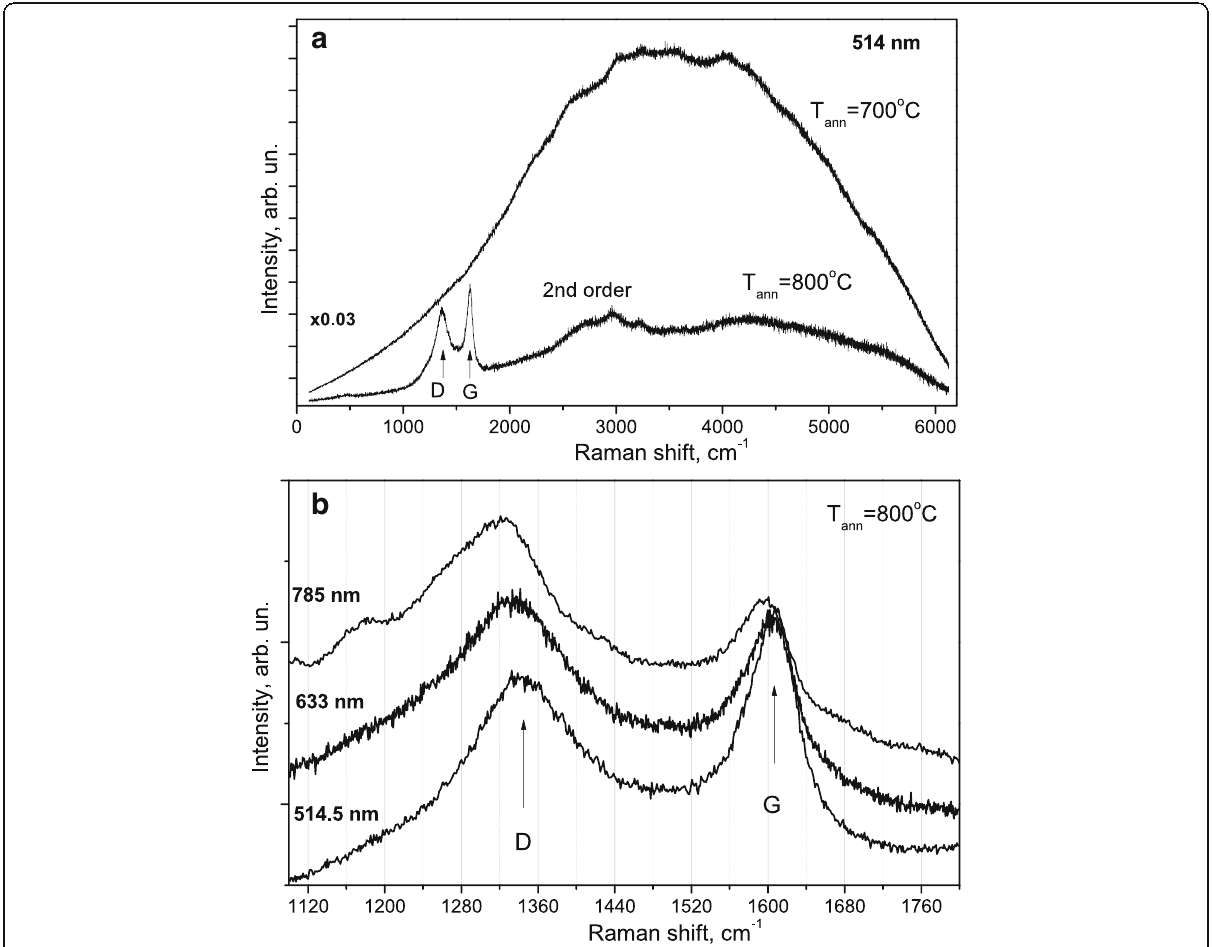
Fig. 3 The comparison of Raman spectra measured in SiO 2 :C samples annealed at 700 and 800 °C with 514.5 nm excitation ( a ) along with the Raman spectra measured in SiO 2 :C sample annealed at 800 °C with different excitations ( b